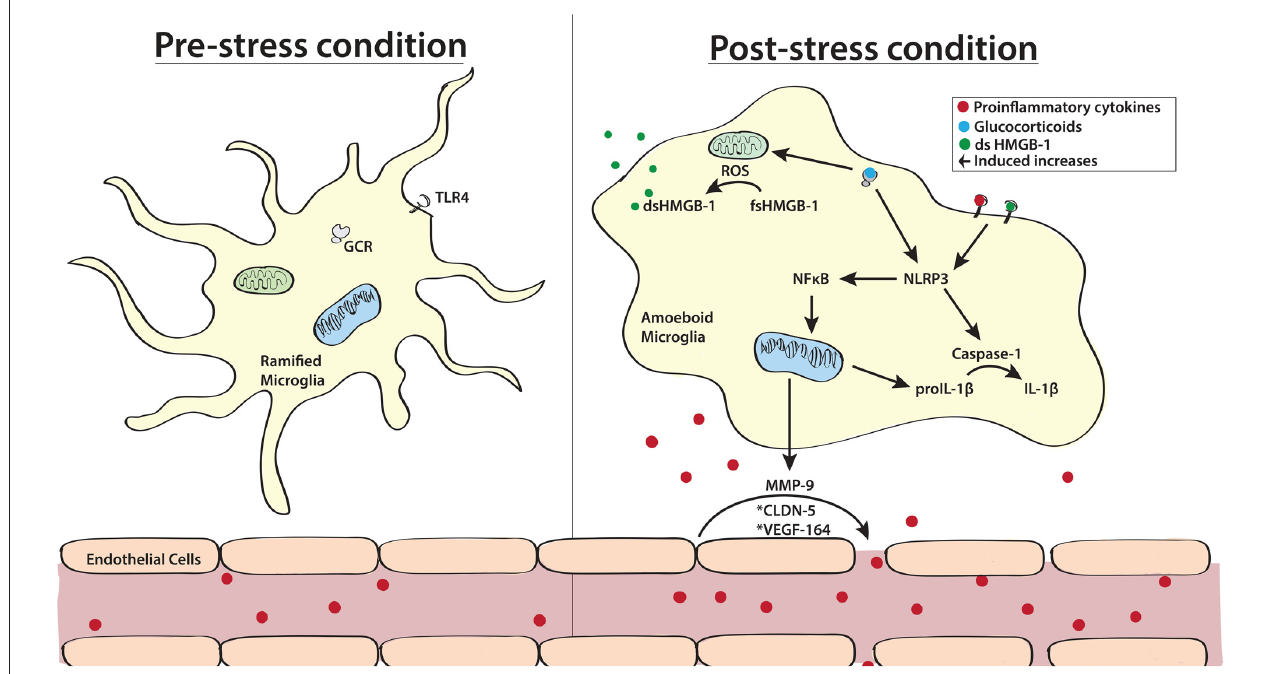
FIGURE 1 | Schematic highlighting key sources of stress-induced neuroinflammation. Stress exposure is known to promote shifts in microglial morphology from a highly ramified “resting” state to an ameboid M1 proinflammatory state. In addition to directly stimulating the release of cytokines, activation of microglial glucocorticoid receptors (GCRs) also results in priming of inflammatory responses. This process can occur directly through activation of the NLRP3 inflammasome or indirectly by promoting the release of reactive oxygen species (ROS) from mitochondria which results in the oxidation of high mobility group box -1 (HMGB-l). Once released, HMGB-1 and proinflammatory cytokines such as interleukin (IL)-1 β can act on toll like receptor 4 (TLR 4) on the surface of microglia to further stimulate the NLRP3 signaling cascade. Another significant source of stress-induced neuroinflammation is the breakdown of the blood brain barrier (BBB). In pre-stress conditions endothelial cells tightly adhere to one another, blocking the flow of circulating cytokines to the brain. However, in response to stress exposure, tight junctions between these endothelial cells break down allowing for peripheral cytokines and inflammatory cells to penetrate into the brain. This process is known to be facilitated by plasma vascular endothelial growth factor (VEFG)-164, endothelial claudin-5 (CLDN-5) and microglia released matrix metalloproteinase-9 (MMP-9). ∗ Designate non-neuronal and non-glial origins.